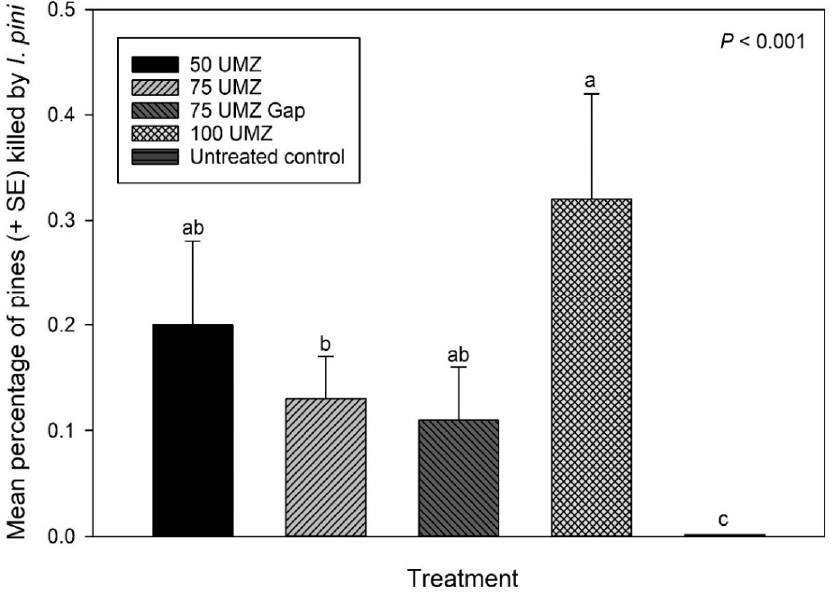
Figure 5. Mean percentage of pines (including ponderosa pine ( Pinus ponderosa ), lodgepole pines ( P . contorta ) and western white pines ( P . monticola )) killed by pine engraver ( Ips pini ) following thinning and prescribed burning at Pringle Falls Experimental Forest, Oregon. Means (+SE) followed by the same letter are not significantly different ( p >